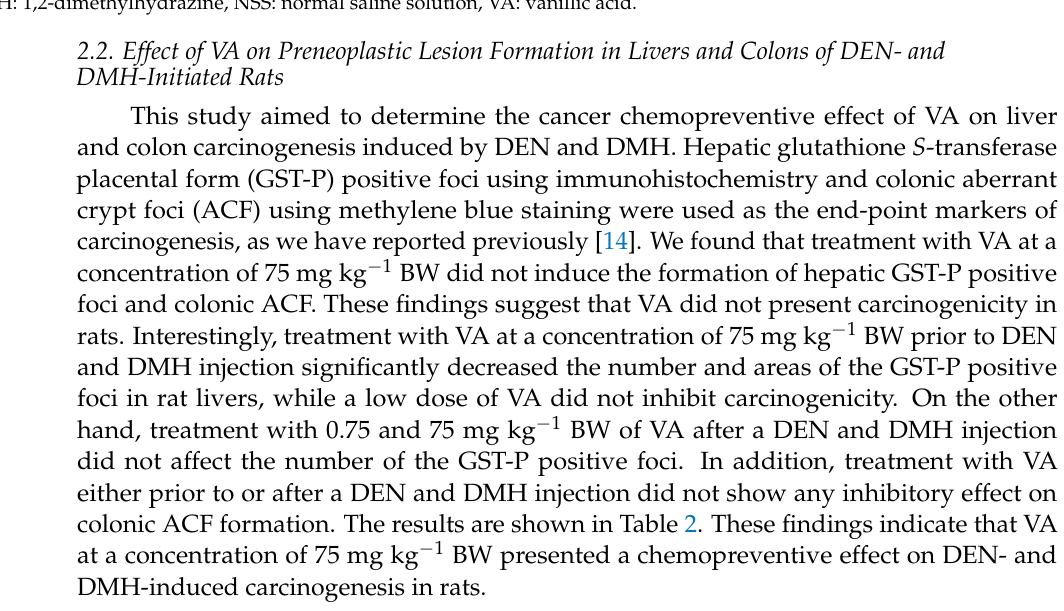
Table 2. The effect of VA on the number of the GST-P positive foci and ACF in DEN- and DMH- initiated rats. Treatment Week of